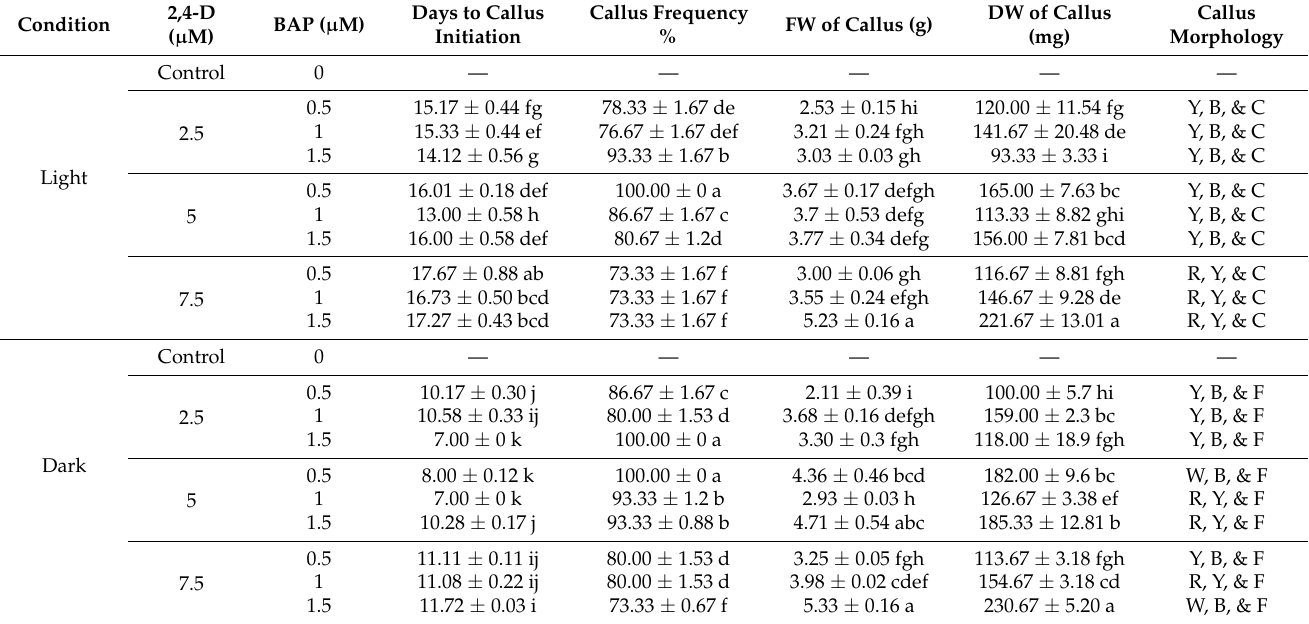
Table 2. Interaction effects of 2,4-D and BAP on callus induction in the nodal segment of Bougainvillea glabra under different light